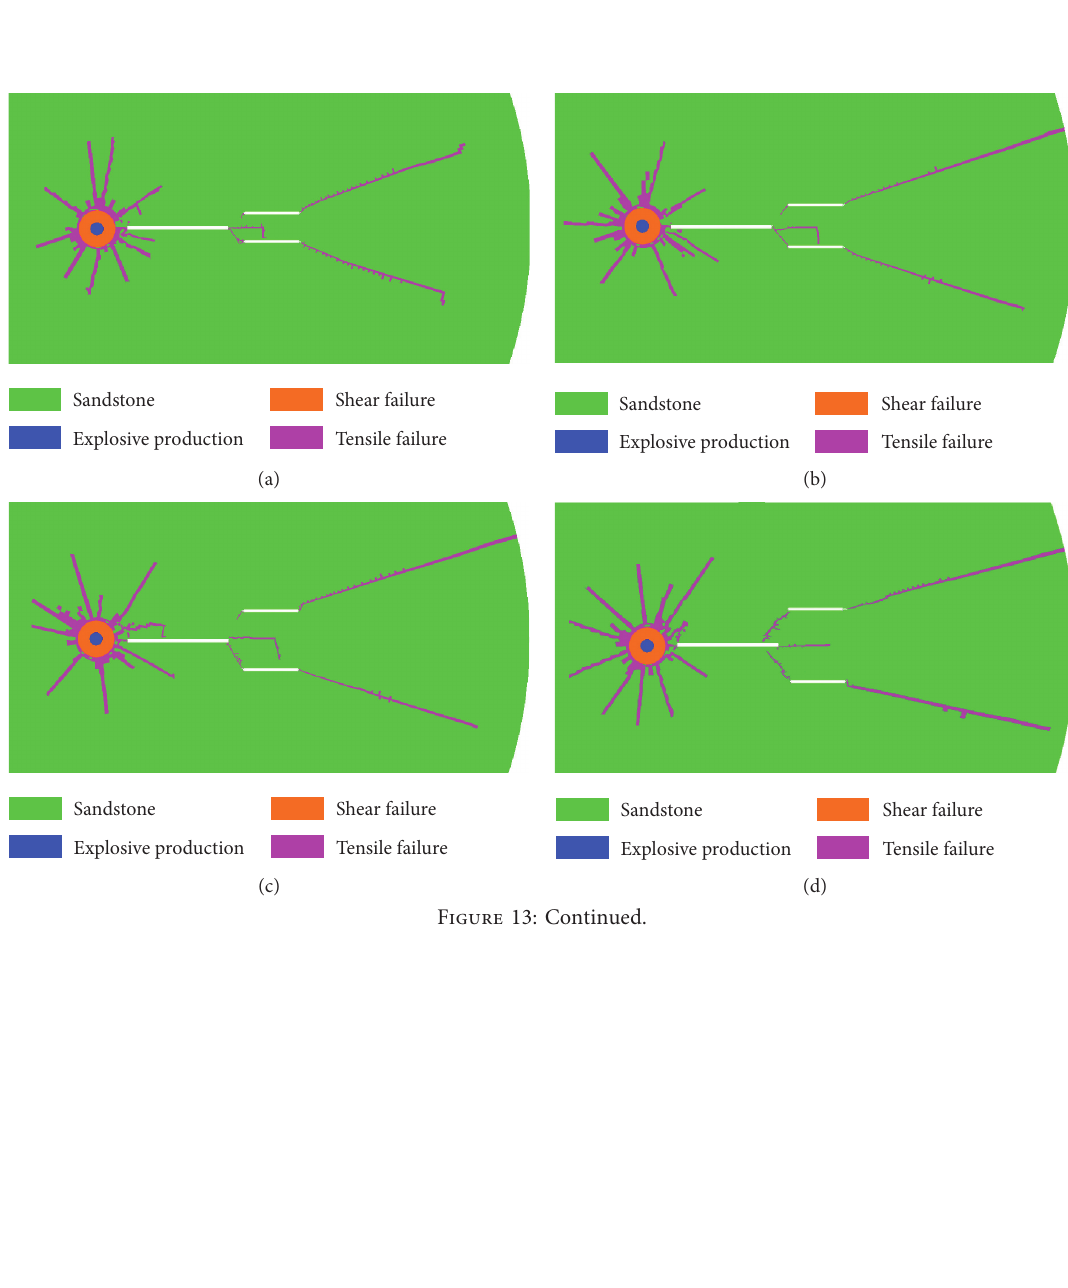
Figure 12: Meshing of a sandstone specimen by using quadrilateral